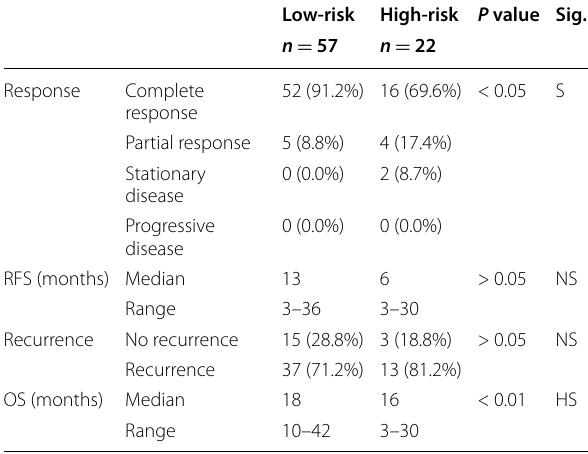
Table 6 Response, recurrence, OS, RFS in patients with AFP levels < 100 after classification into the low- and high-risk groups by the AFP model